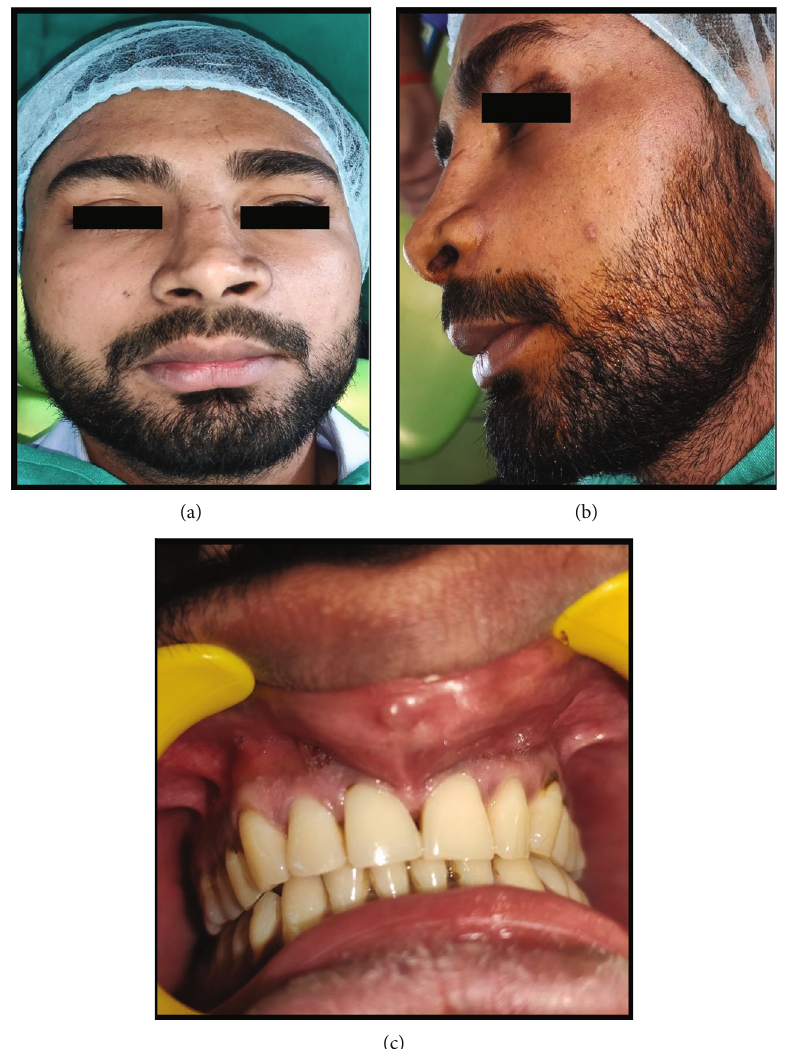
Figure 1: (a) and (b) Extraoral swelling on the left mid-facial region. (c) Intraoral swelling in the maxillary anterior